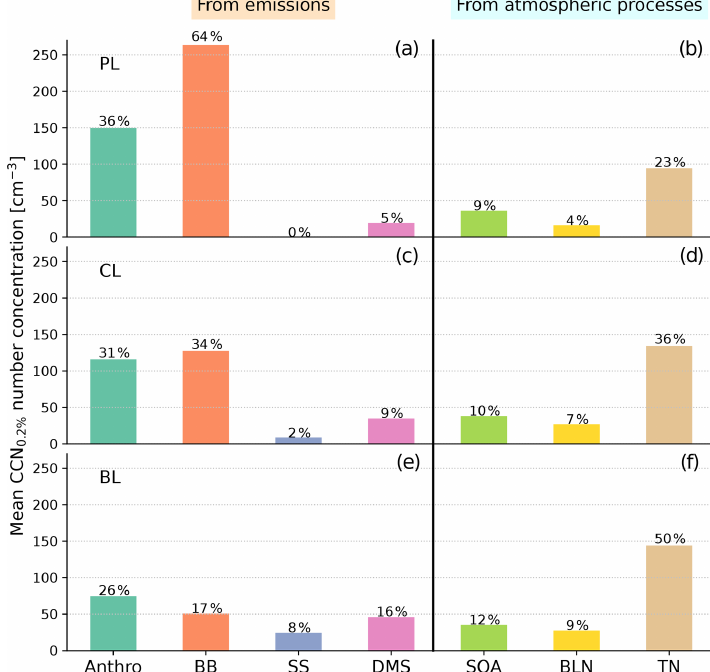
Figure 5. UKESM1-simulated annual mean CCN concentration at 0.2% supersaturation (CCN 0 . 2% ) in the cloud box region from different sources and in different layers. Panels (a) and (b) , (c) and (d) , and (e) and (f) represent CCN 0 . 2% attribution in the plume layer (PL), cloud layer (CL), and marine boundary layer (BL) respectively. Panels (a) , (c) , and (e) indicate the contribution of emission sources, including anthropogenic (Anthro), BB, sea-salt (SS), and DMS sources, to CCN 0 . 2% . Panel (b) , (d) , and (f) indicate the contribution of atmospheric processes, including SOA, boundary layer nucleation (BLN), and total aerosol nucleation (TN), to CCN 0 . 2% . BLN is based on organic- mediated aerosol nucleation and is limited to the boundary layer. TN includes BLN and homogeneous binary aerosol nucleation in the free troposphere and stratosphere. Using the simulation of the present day as the baseline (annual mean CCN 0 . 2% of around 290cm − 3 ), the contribution of each source to CCN 0 . 2% is marked at the top of the corresponding bar as a